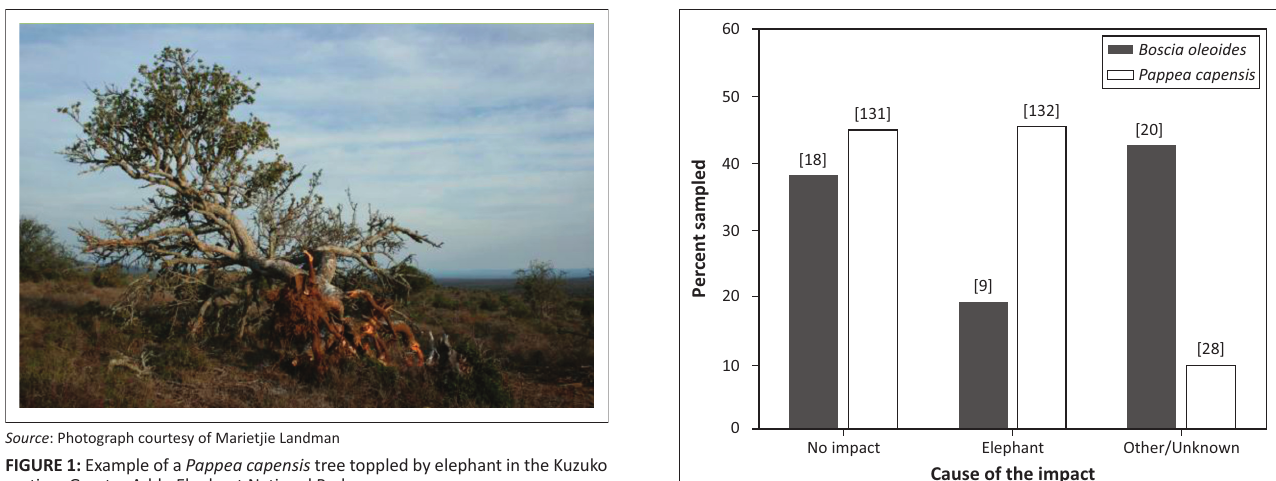
FIGURE 1: Example of a Pappea capensis tree toppled by elephant in the Kuzuko section, Greater Addo Elephant National